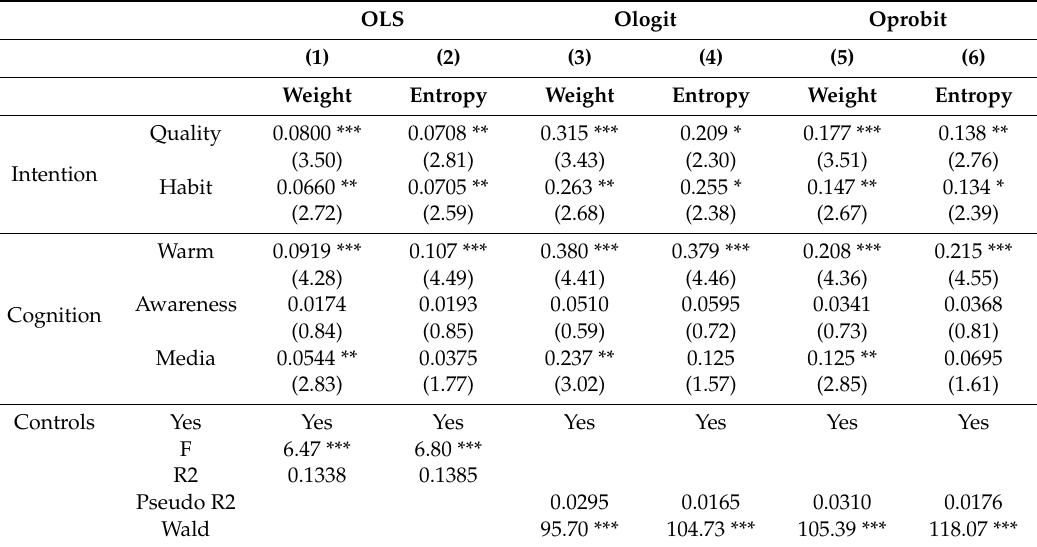
Table A3. Regression results when work and register are set as dummy